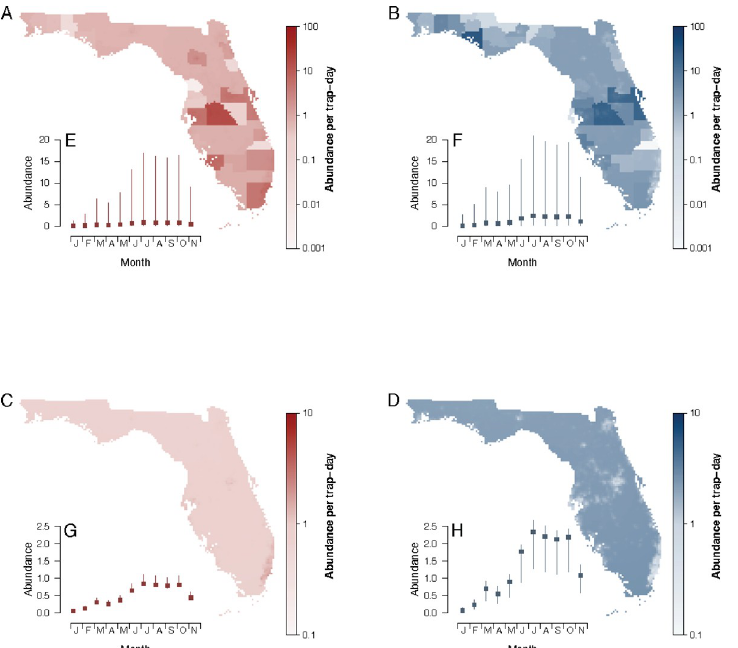
Fig 5. Maps of predicted abundance of Aedes aegypti (red, A and C) and Aedes albopictus (blue, B and D) on August 1, 2018 in Florida. Predictions are derived from “no abundance model”. Parts A and B show results incorporating random effects which represents differences in trapping counts by county. Parts C and D show results only incorporating fixed effects. Predictions for each month in 2018 are shown in S3 Video. E–H, points and vertical lines are the median and interquartile range of the corresponding predictions across the state at each time point. Maps produced using R Version 3.5.0 (R Foundation for Statistical Computing, Vienna, Austria). Source of shapefile: Southwest Florida Water Management District (https://geodata.myflorida.com/datasets/swfwmd::florida-counties).